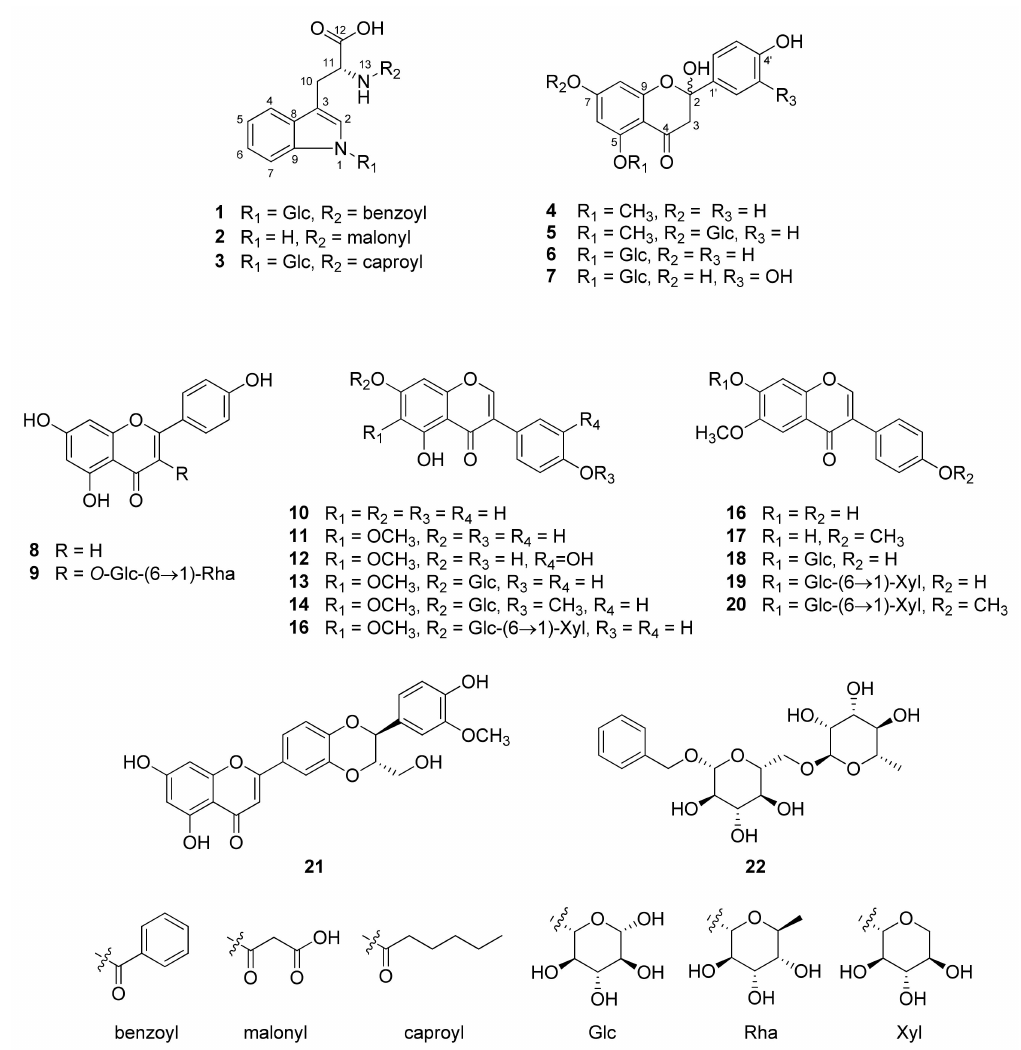
Figure 1. Structures of compounds 1 – 22 isolated from Puerariae